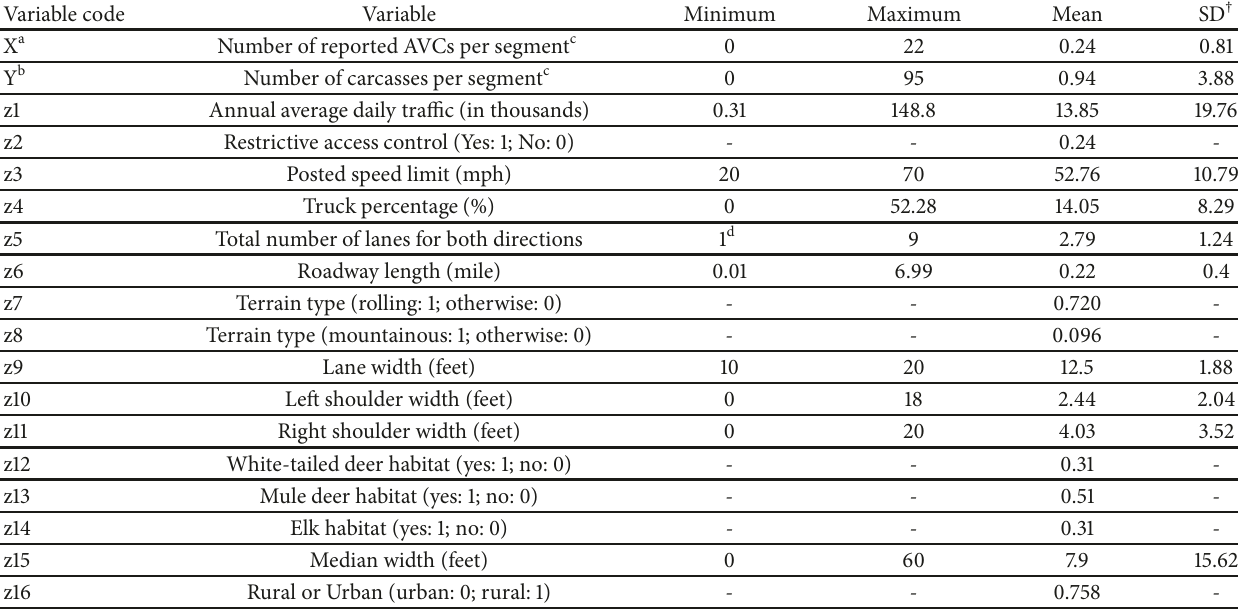
Table 3: Summary statistics of characteristics for reported AVCs and carcasses in the Washington data.